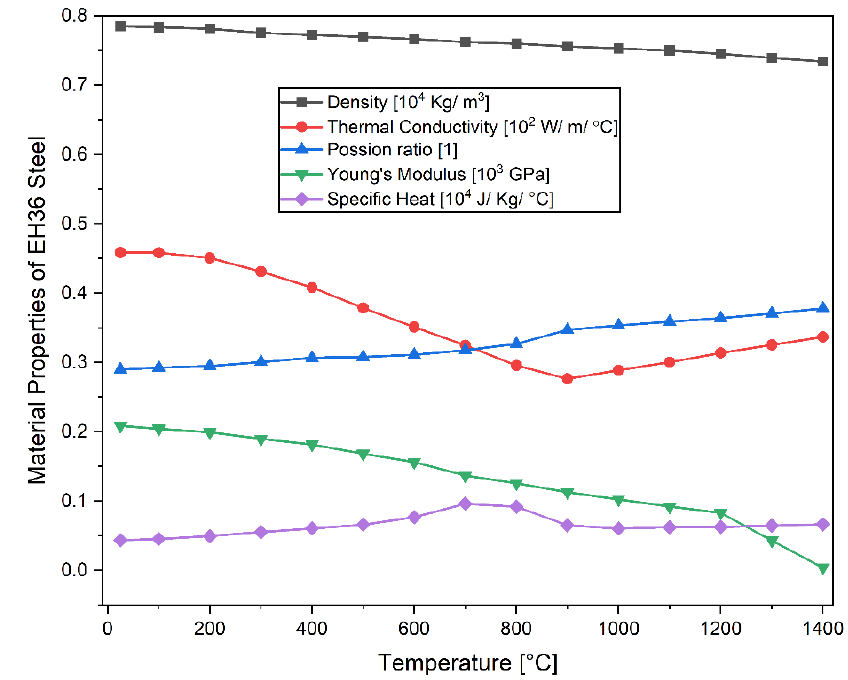
Figure 1. Temperature-dependent material properties of EH36 steel, adapted from [10].